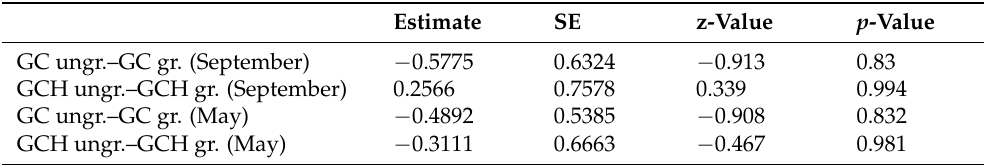
Table A26. Differences in Chao diversity index, comparing the grazed pastures and ungrazed strips of the grass–clover (GC) and the grass–clover herbs (GCH) in May/June and September.